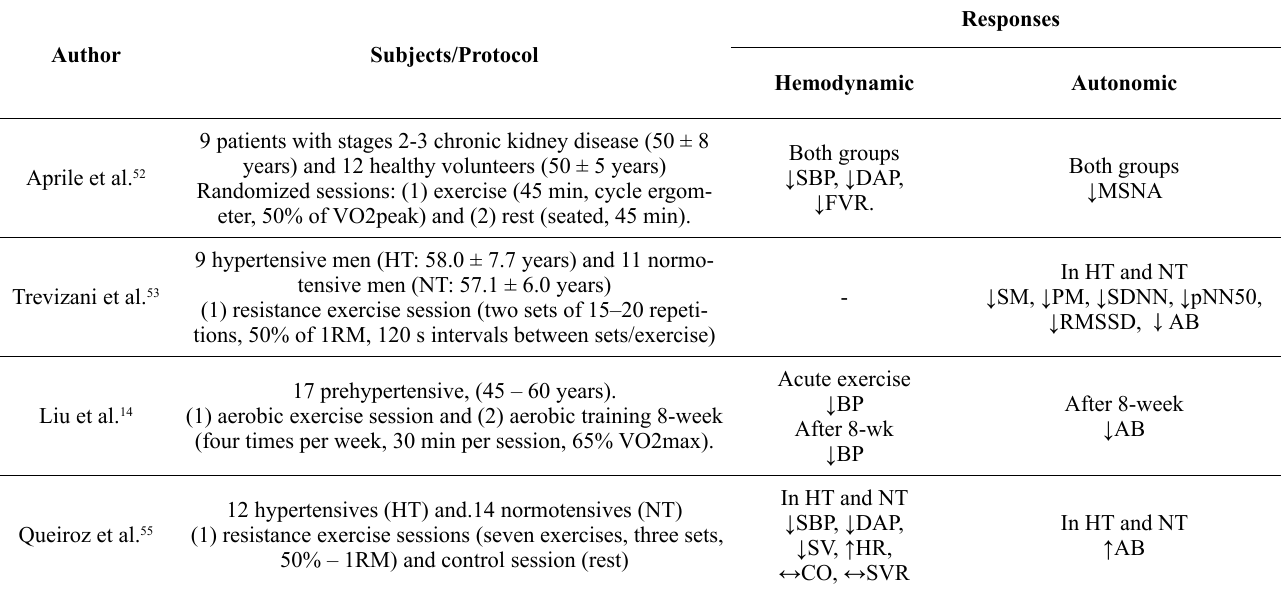
Table 1. The effect of physical exercise on autonomic and hemodynamic